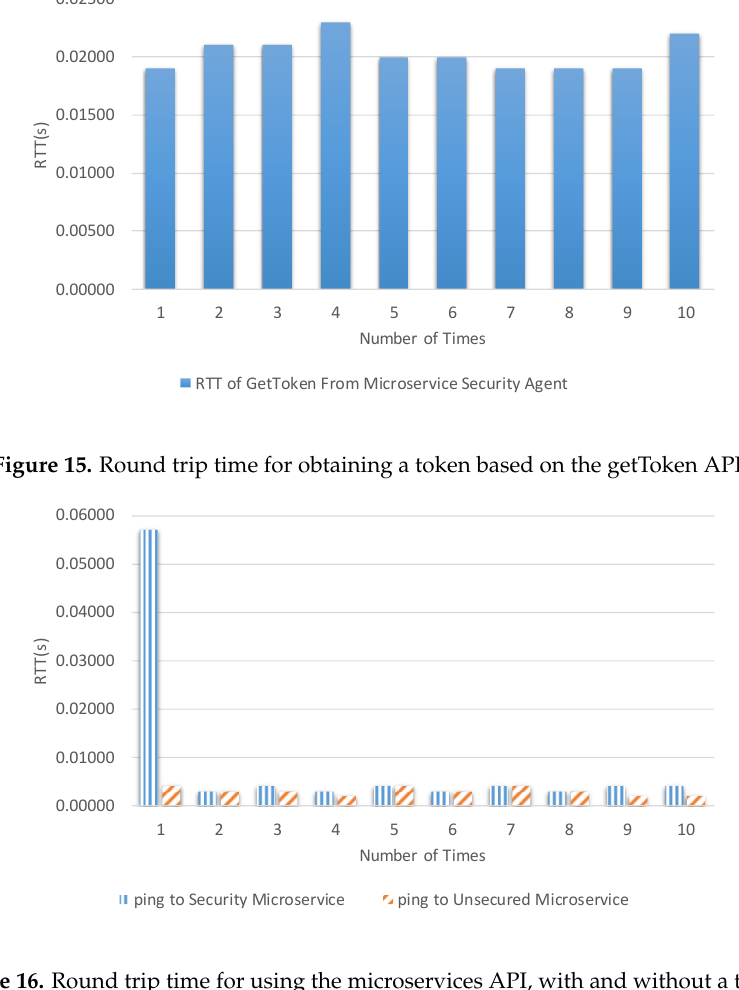
Figure 16. Round trip time for using the microservices API, with and without a